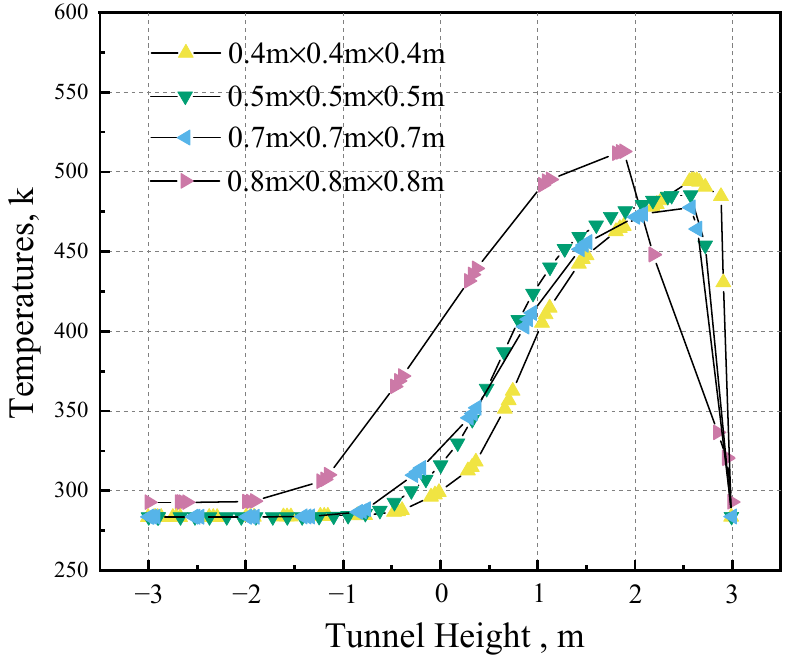
Figure 4. Vertical temperature variation with different grid sizes.